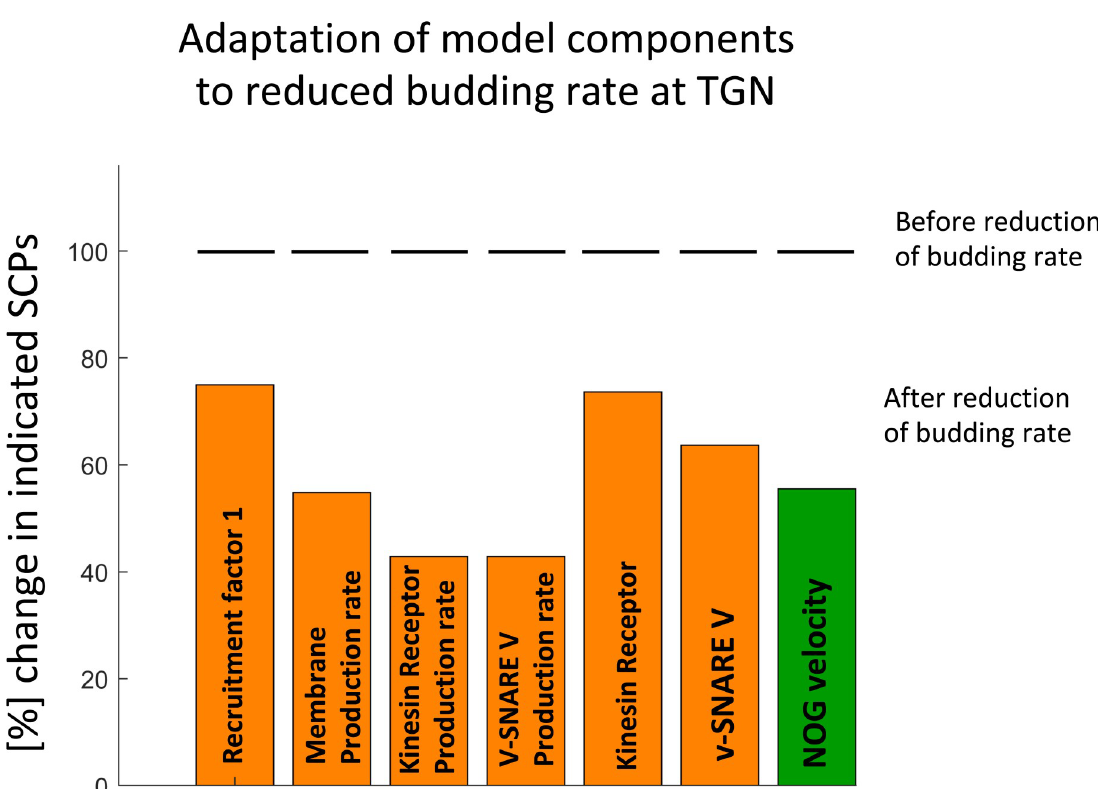
Fig 8. Loss of function of Level-2 SCPs requires multiple adaptations to allow NOG under physiological conditions. We predicted a parameter set that allows steady neurite outgrowth with a velocity of 10 μ m/h. To investigate Level-2 SCP dependencies we reduced the activity of the SCP Vesicle budding at the TGN by reducing the amount of Recruitment Factor 1 without compensatory increase of the budding rate. In consequence, the activities of multiple Level-2 SCPs needed to be coordinatively adapted to secure neurite outgrowth under physiological conditions (as defined by our model constraints). One possible adaptation involves the reduction in the activity of the SCPs Membrane Lipid Production , of Anterograde Microtubule-Based Vesicle Transport (via reduced kinesin receptors), of Vesicle Exocytosis (via reduced v-SNARE V) and of Membrane Protein Production of the involved transmembrane molecules. Since this option includes a constant cycling rate (i.e. rate of back transported membrane), it causes a reduction in neurite outgrowth